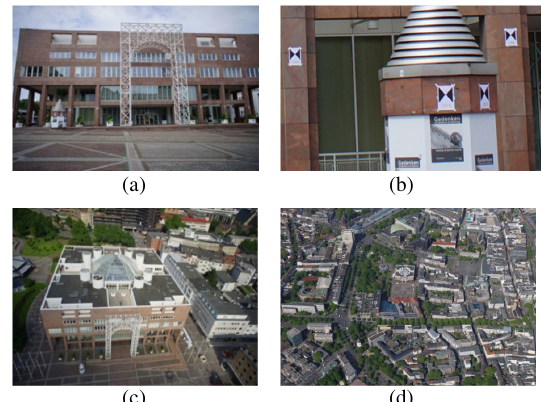
(d) Figure 3. City centre dataset - City hall Dortmund: a) terrestrial image, b) zoom in to show some targets, c) UAV oblique image, d) IGI Pentacam image.